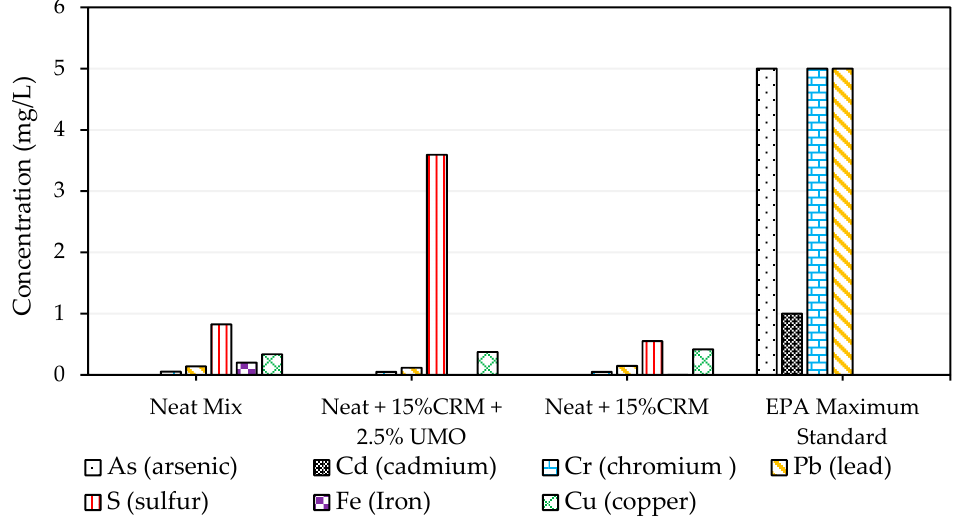
Figure 20. TCLP results for PG 52-28 neat and modified mixtures compared to EPA standards for heavy metals.